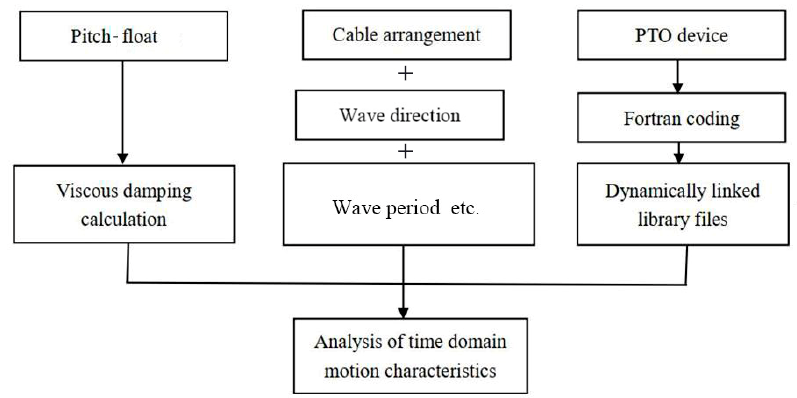
Figure 4. The time domain analysis flowchart of the generator motion.